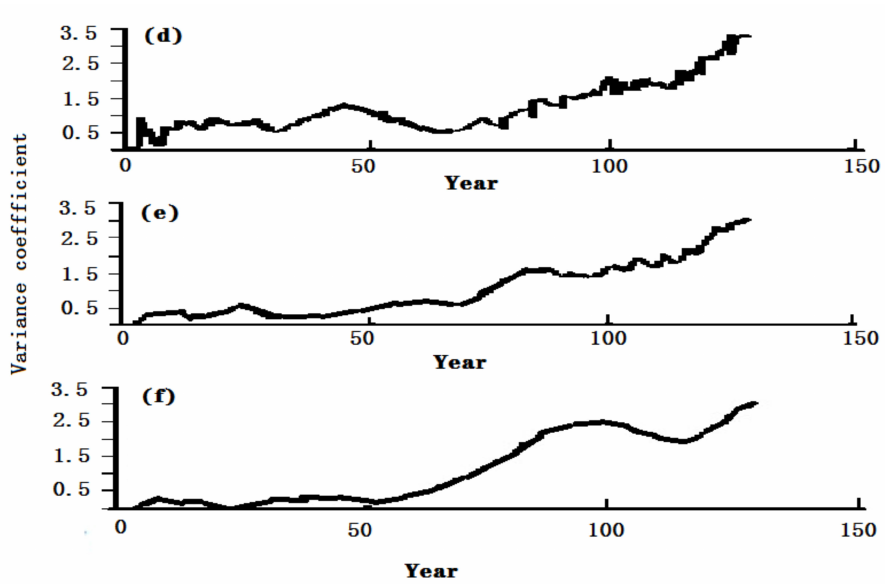
Figure 6. Real part and variance changes of wavelet coefficients of droughts and floods. ( a ): year;